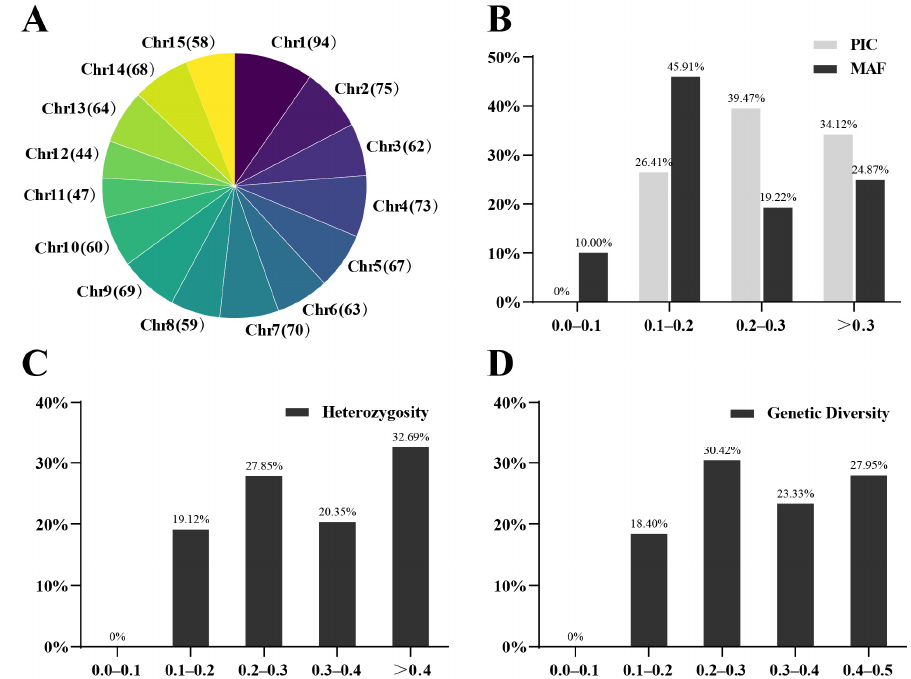
Figure 3. Genetic diversity analysis with 973 core SNPs in the 349 tea trees. ( A )The number of 973 SNPs distributed on 15 chromosomes; ( B ) Polymorphic information content (PIC) and minor allele frequency (MAF); ( C ) observed heterozygosity (Ho); ( D ) genetic diversity